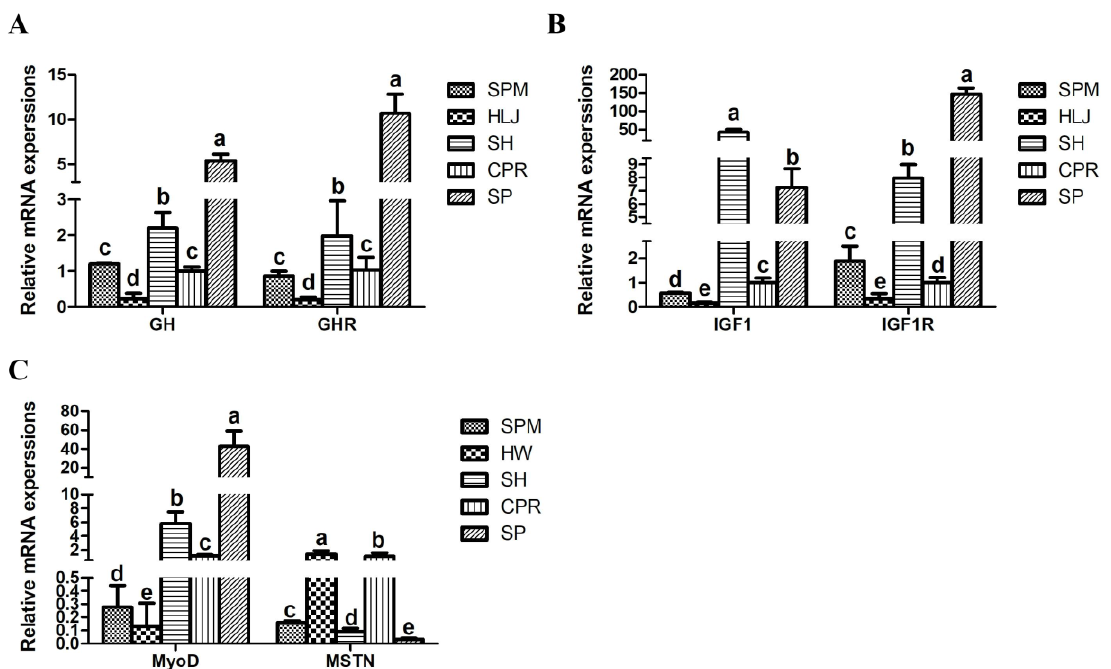
Figure 4. Relative genes expression of growth-related genes in the muscles in five species of common carp. The mRNA expression of growth-related genes produced a relative fold value compared to that of CPR. Lowercase letters indicate significant effects on the relative gene expression of growth-related genes ( p < 0.05). Note: ( A ) GH and GHR , ( B ) IGF1 and IGF1R , ( C ) MyoD and MSTN .